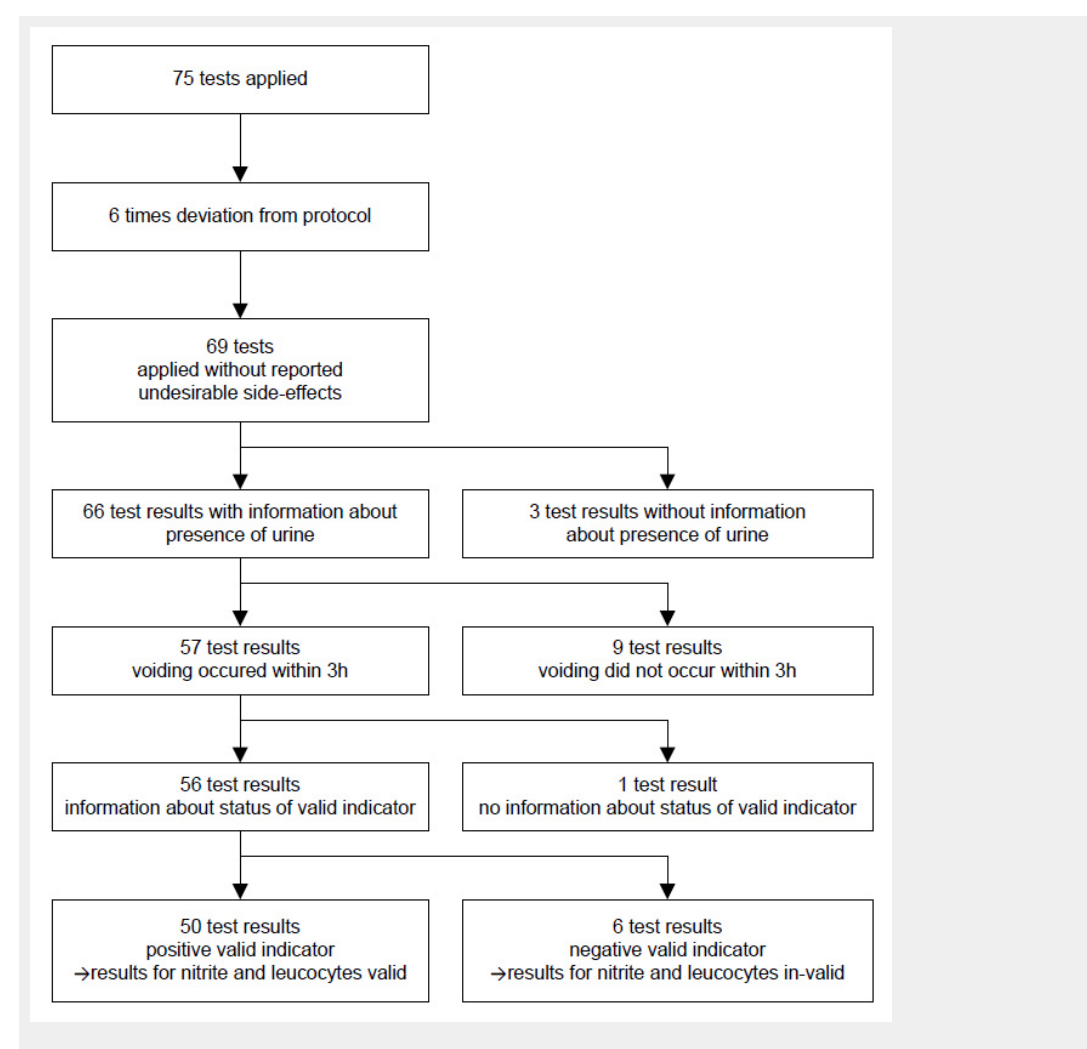
Figure 2 Results of the clinical study for the qualitative parameters